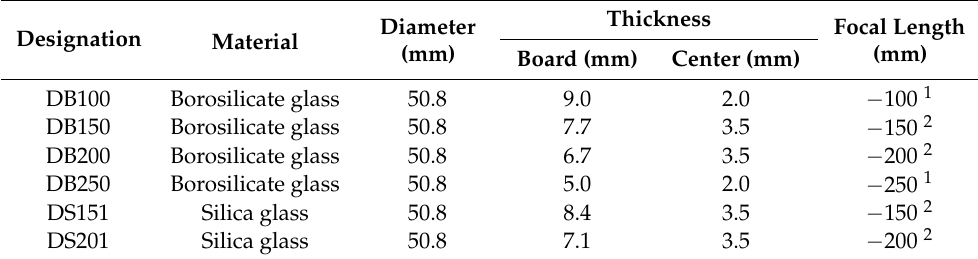
Table 1. Diverging (biconcave) lenses tested in this work.